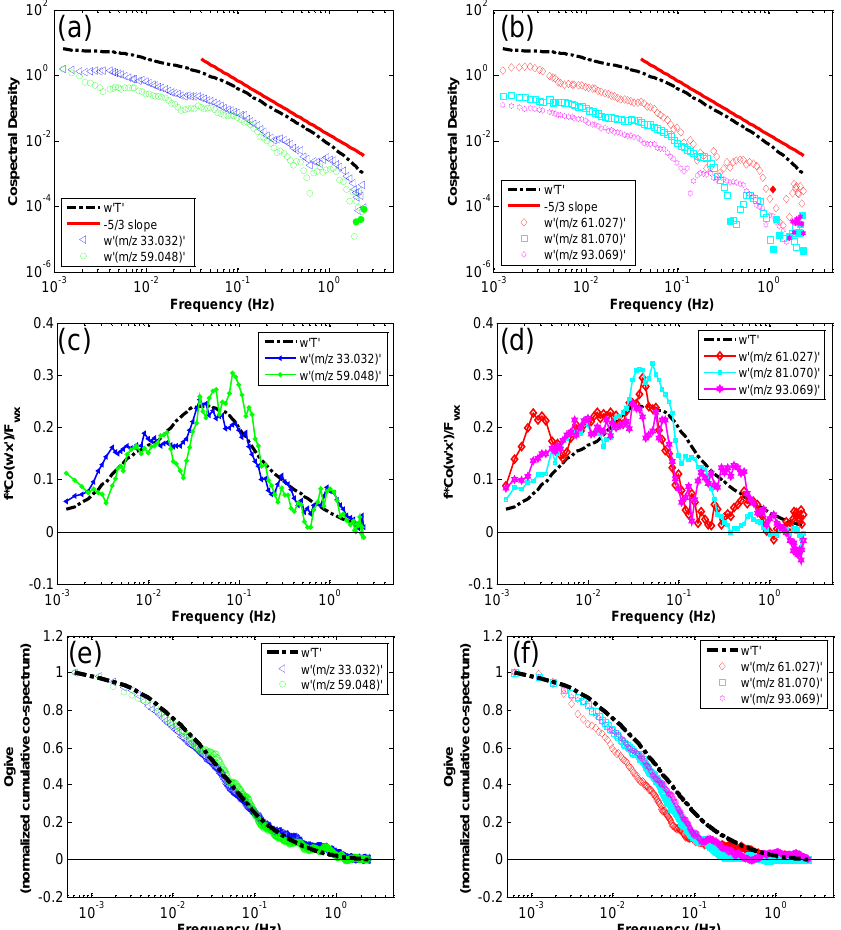
Fig. 5. Cospectral density (a, b), frequency weighted covariance normalized cospectra (c, d), and normalized cumulative cospectra or ogive (e, f), of five dominant BVOC (colored open symbols) and sensible heat (black broken line) binned into 100 evenly spaced intervals along the frequency axis. Each closed symbol in (a) and (b) represents negative values.